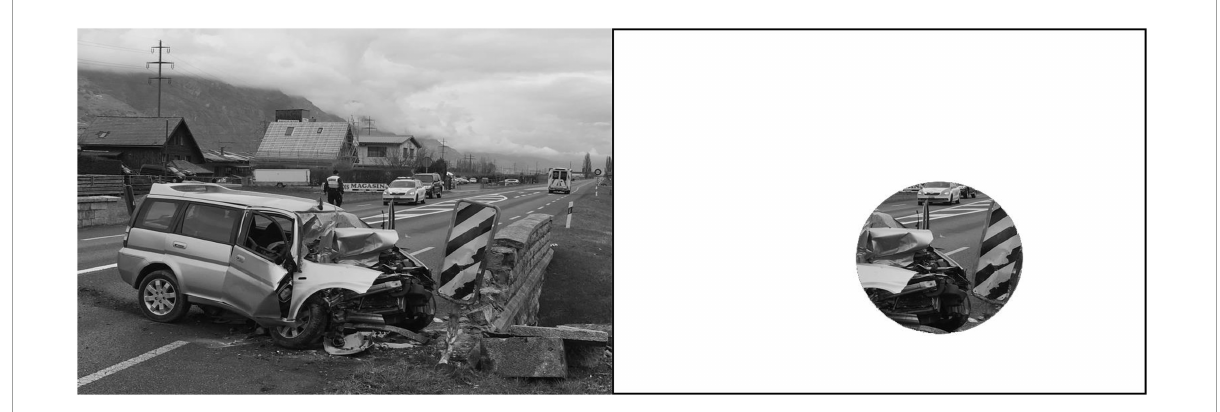
FIGURE3 Left: Focal-high pictures that served as a source of patch construction. Right: The patch extracted from pretested pictures and its size in relation to the source picture size. Patches were constructed to give enough cues to allow recognition without providing complete pictures that could lead to new